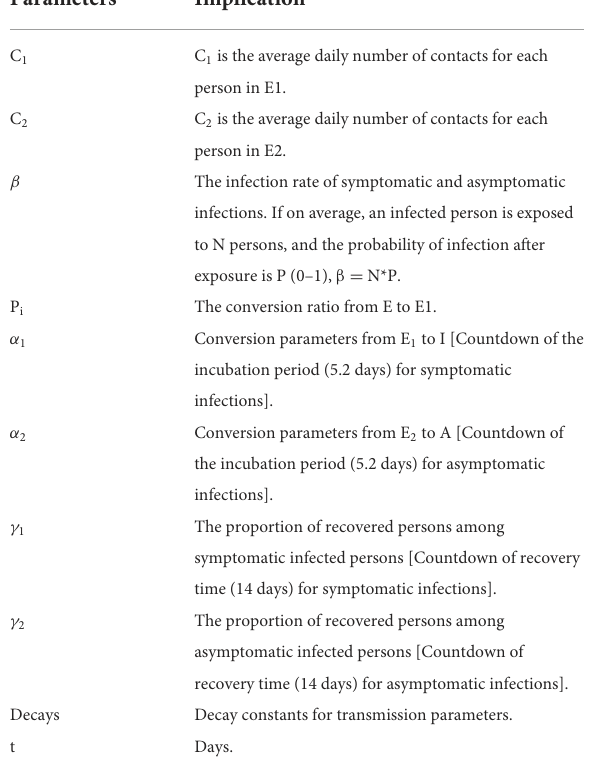
TABLE 1 Description of the model’s parameters.